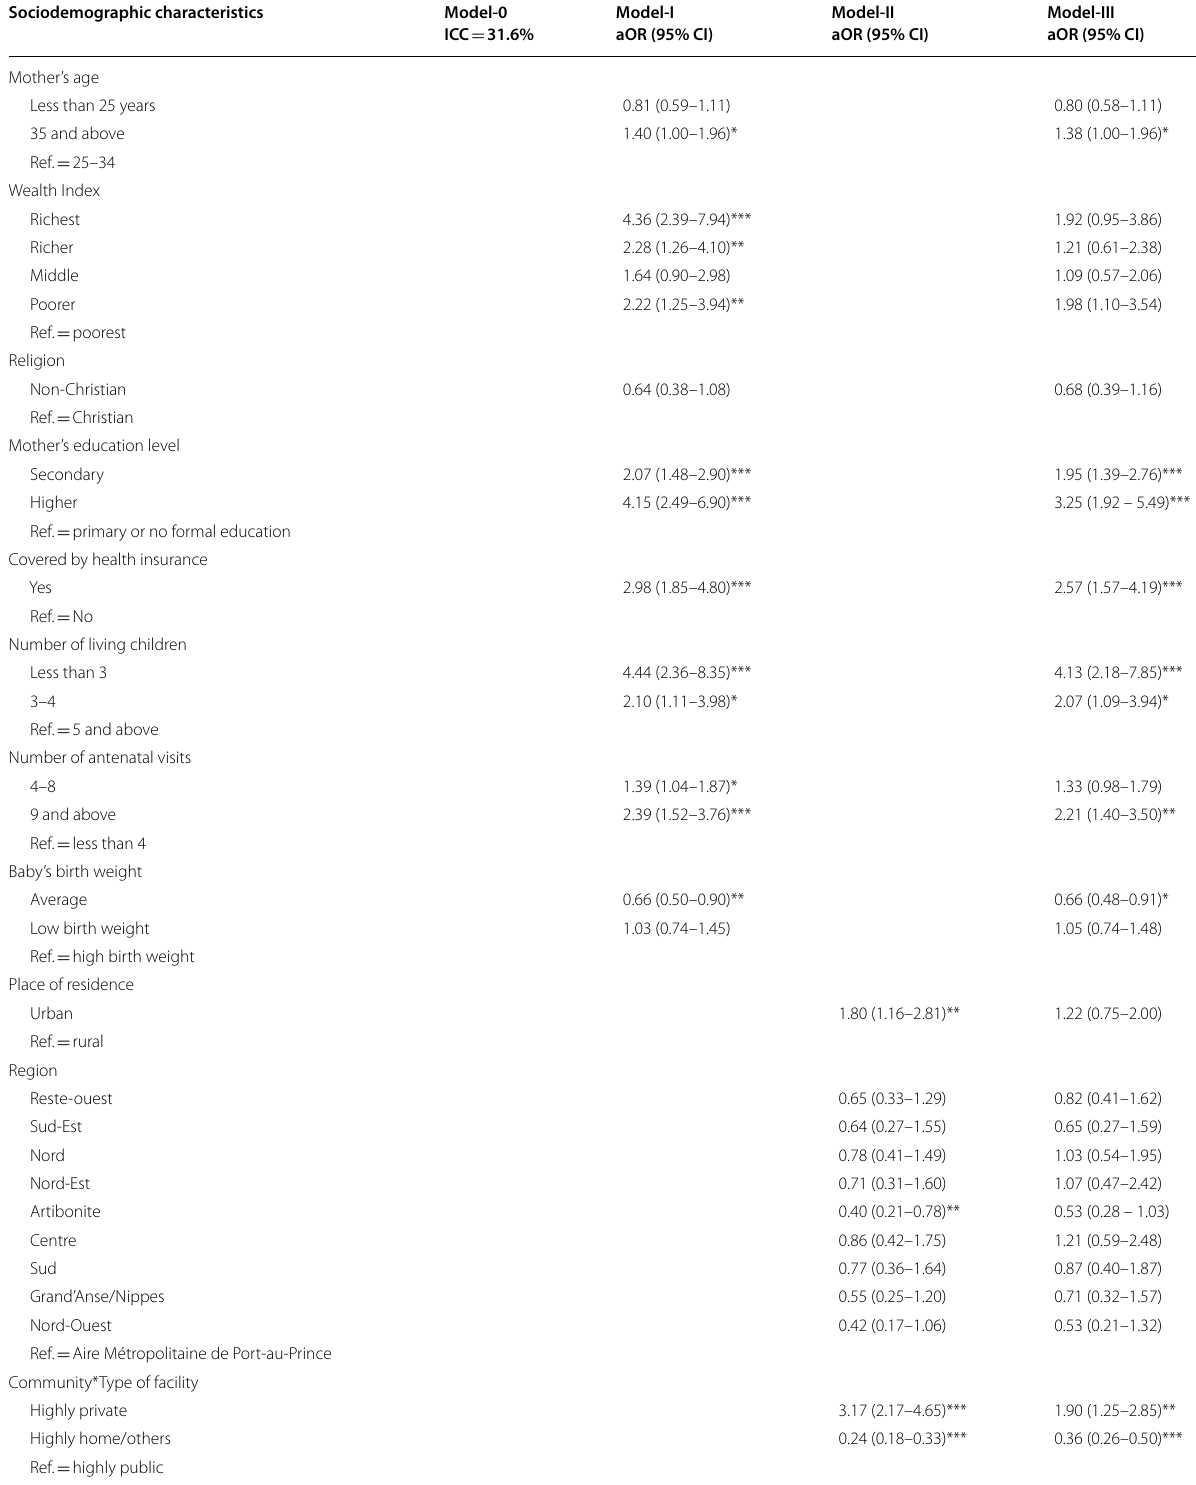
Table 3 Multilevel logistic regression estimates for CS by selected socio‑demographic